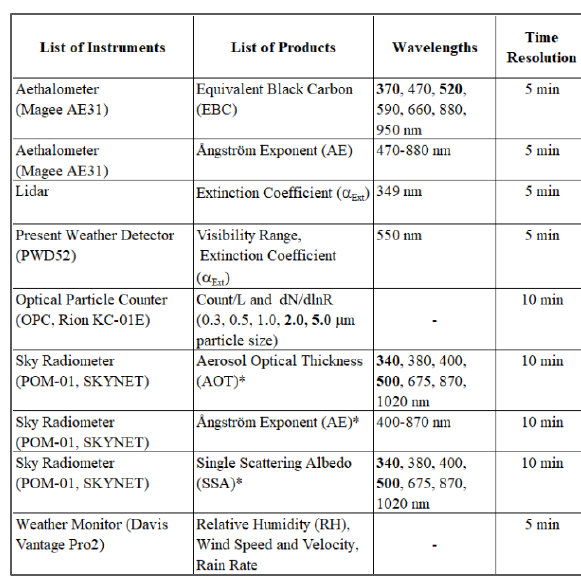
Fig. 1. Schematic diagram of the lidar system.